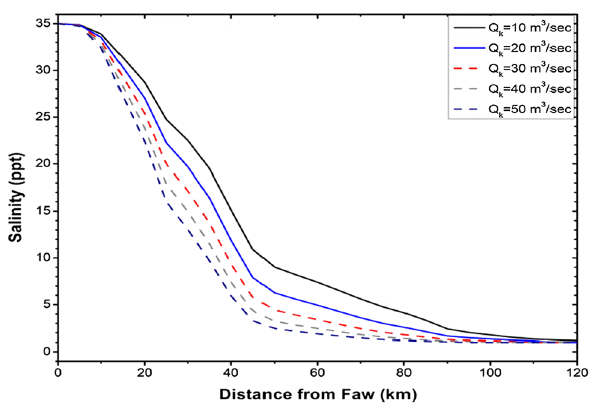
Fig. 5 Salinity intrusion limit corresponding to 25 m 3 /s from Tigris river and different flow rates from Karun river